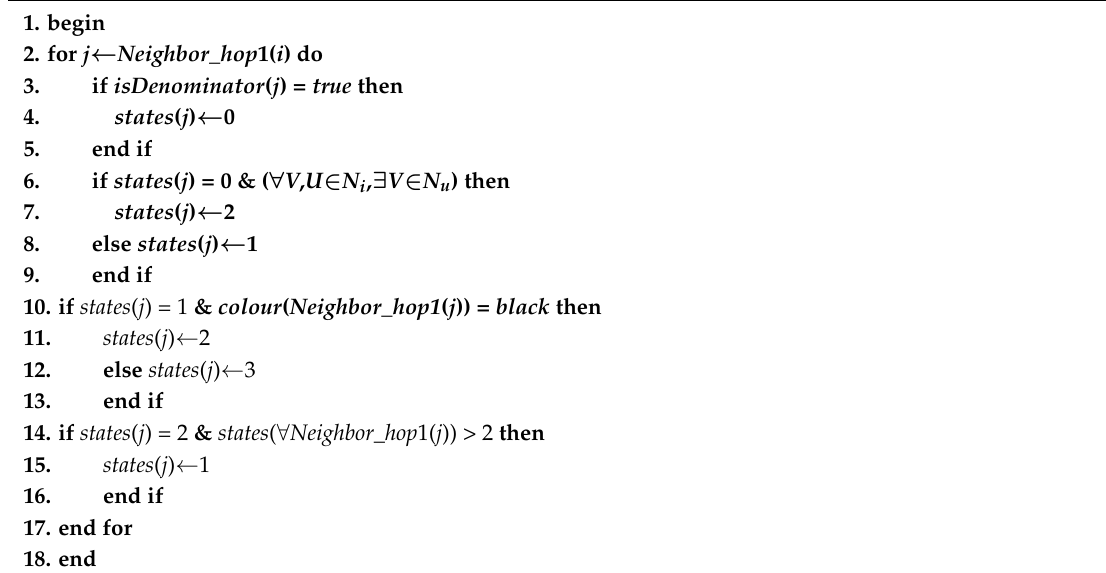
Algorithm 1 Update the Connected Dominating